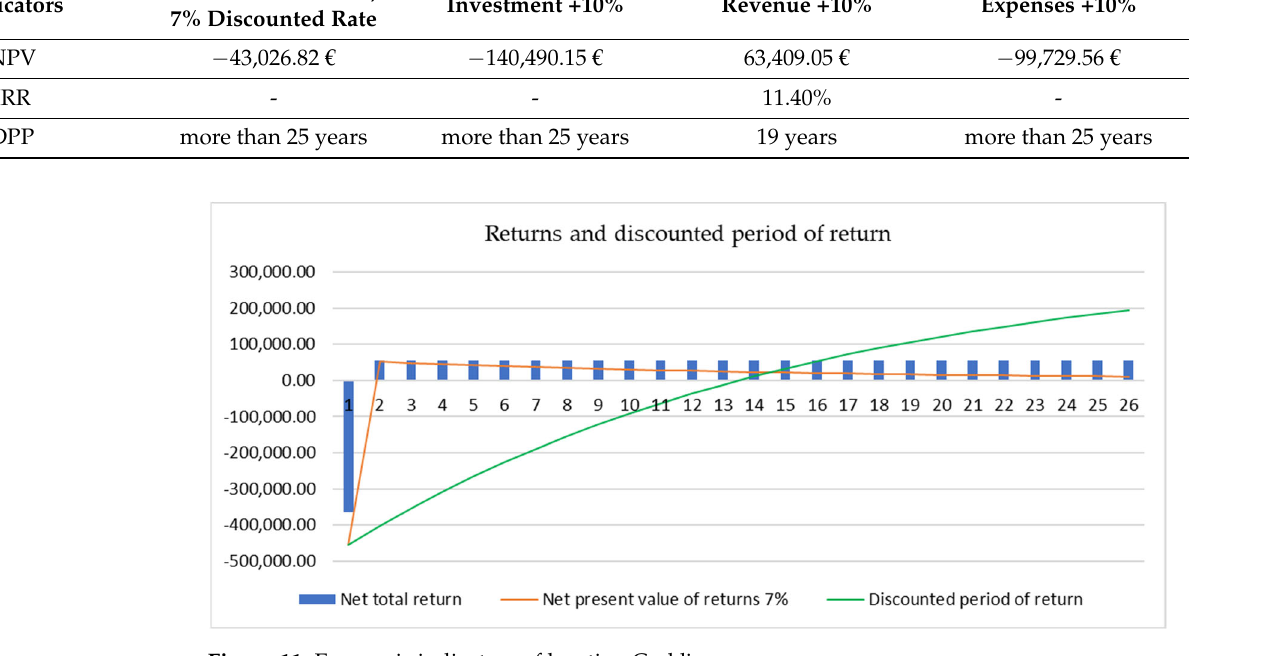
Figure 11. Economic indicators of location Cerklje.